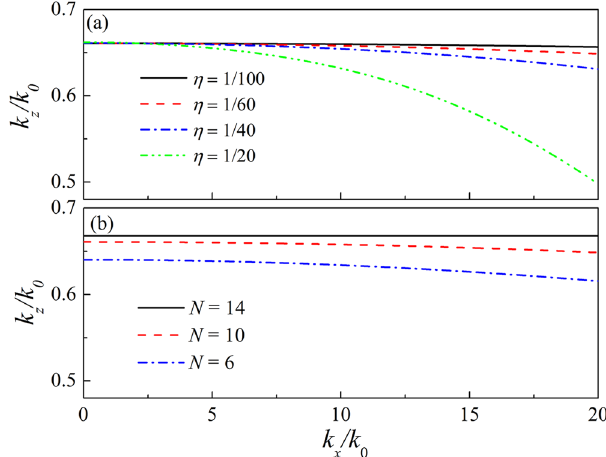
Figure 4. Equifrequency contour plot of the LMMD media for different values of ( a ) η and ( b ) N